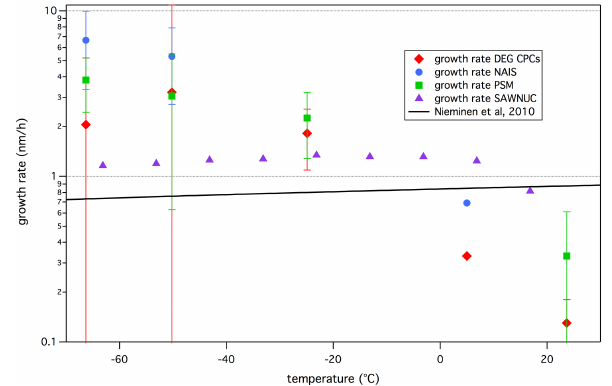
Figure 4. The growth rates normalized to a sulfuric acid concentra- tion of 10 7 cm − 3 as a function of temperature. The GRs have been calculated using the laminar flow DEG-CPCs, the PSMs and the NAIS. Red symbols show the average growth rates at the given tem- perature determined from the DEG-CPCs, from the NAIS in blue and from the PSMs in green. The error bars show the standard de- viation of the average. The black line shows the expected growth rates based on kinetic collisions of sulfuric acid molecules (Niem- inen et al., 2010). The purple triangles show calculations using the SAWNUC model. The modelled results show a similar temperature trend, as here evaporation is taken into